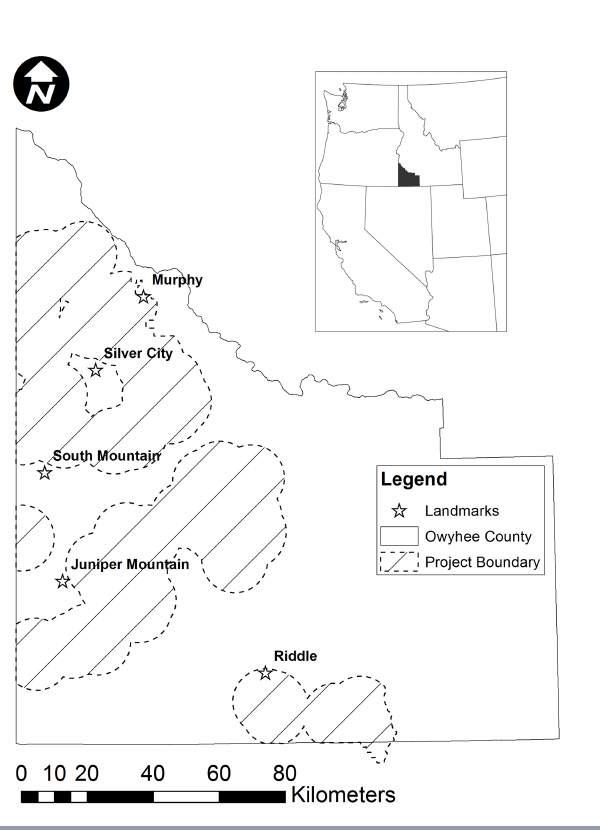
Fig. 1. Map of Owyhee County, Idaho, USA showing the proposed project boundary and five landmarks for the Bruneau-Owyhee Sage-Grouse Habitat project. Inset: Black polygon indicates the location of Owyhee County in western